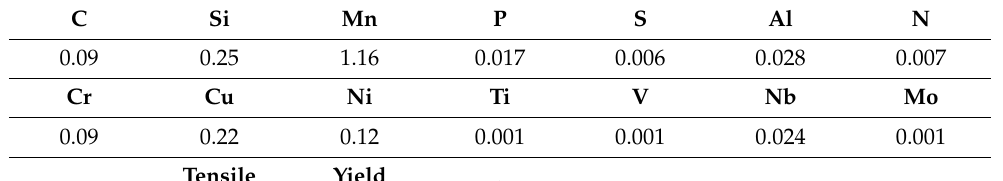
Table 1. Chemical composition of alloying elements in % and observed mechanical properties of AH36 steel [12].